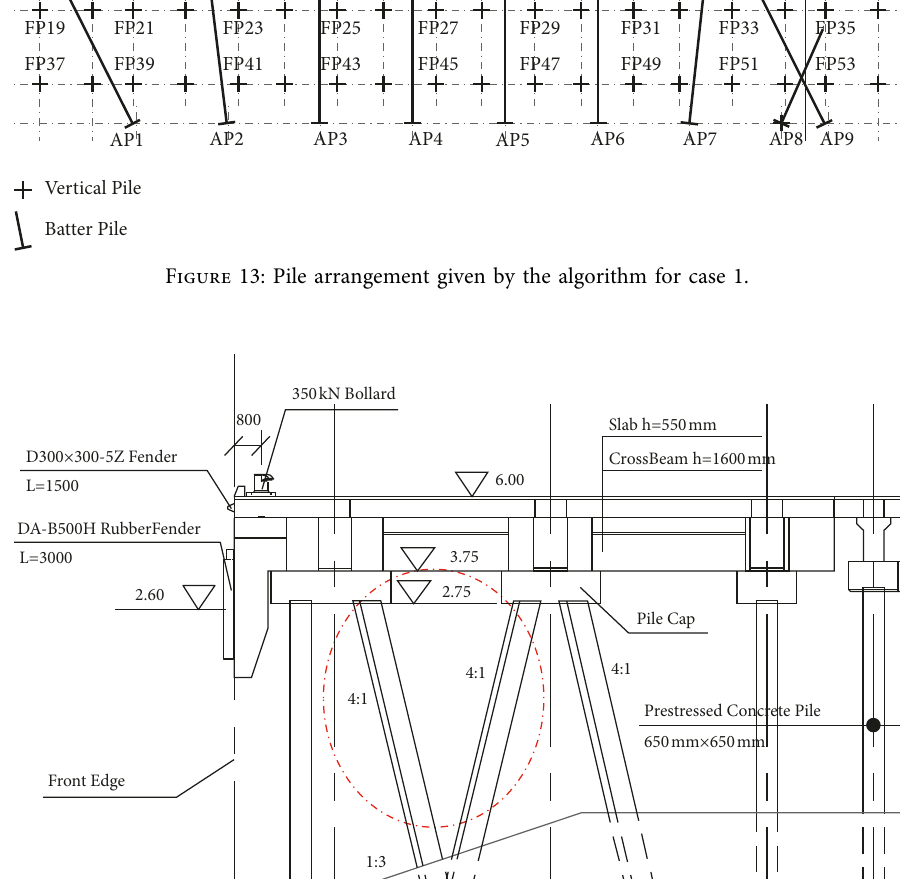
Figure 14: Cross section of the auxiliary working ship berth of an LNG wharf in the south port area of Tianjin Port.